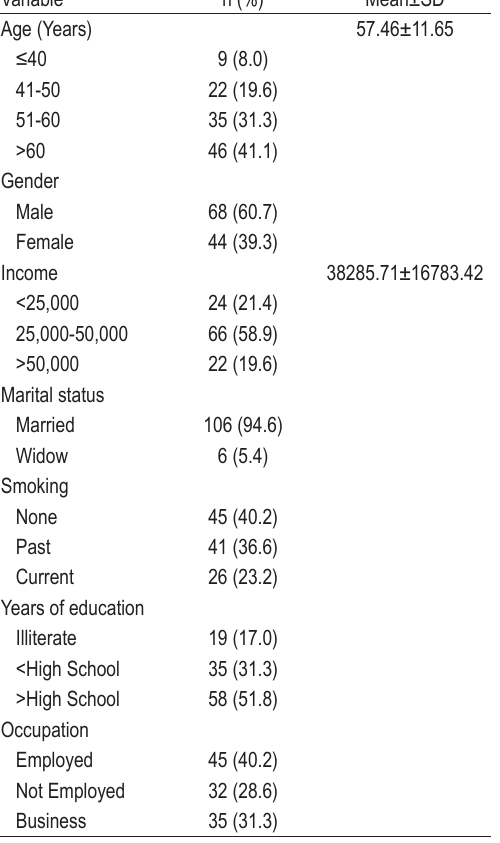
TABLE 1. Distribution of socio-demographic characteristics of among the participants (n-112)